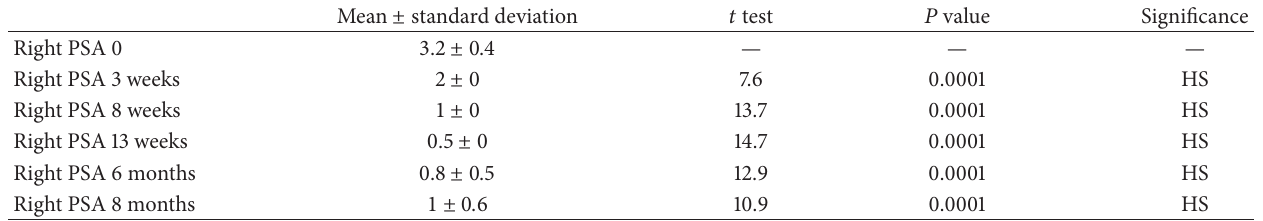
Table 1: Comparison between palm sweating area (PSA) score before treatment and at follow-up visits in the right palm (Botox). Mean ± standard deviation